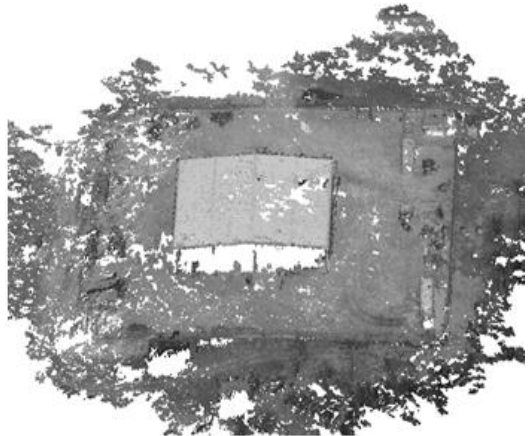
Figure 7. Dense point cloud created by VisualSFM from single circular flight over machine storage area using the NGA